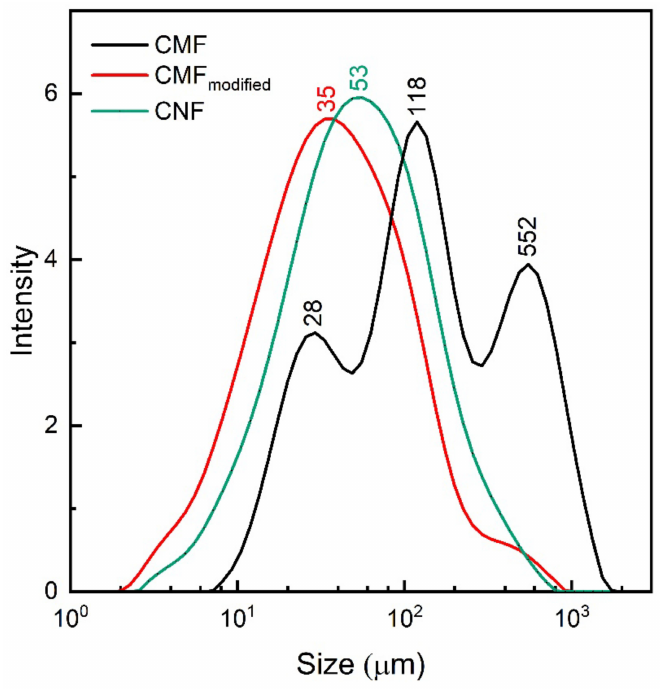
Figure 3. Particle size distribution of the samples: CMF (black), CMF modified (red), and CNF (green).